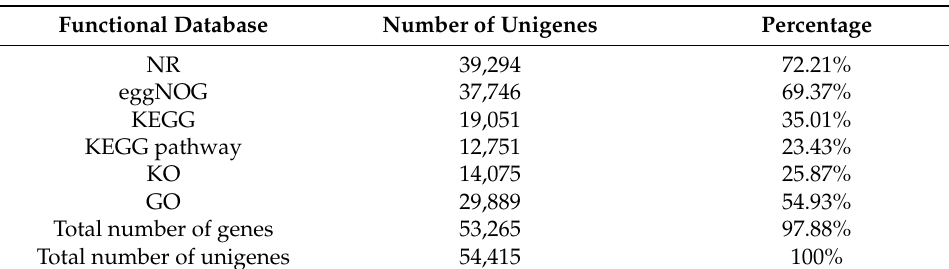
Table 4. Unigenes annotated statistics.